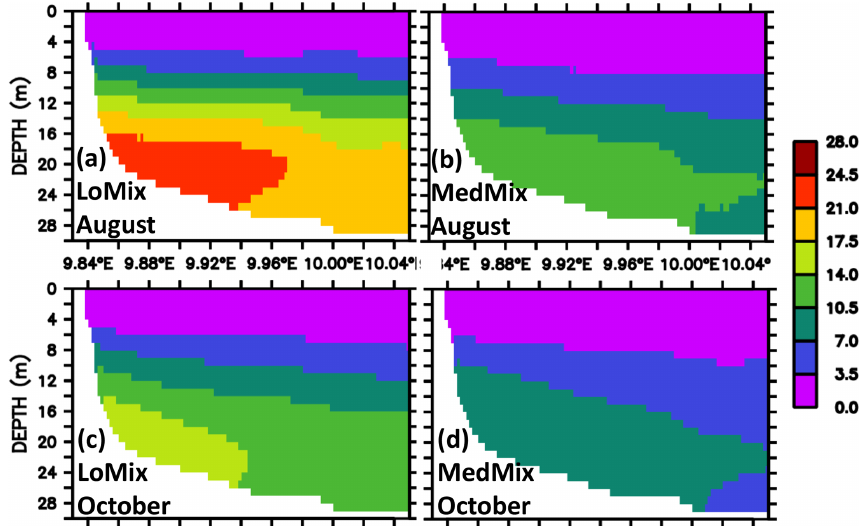
Figure 10. Simulated climatological estimate of local ventilation. The color shading denotes the time elapsed (age) since water parcels have been in contact with the atmosphere in units of days. Sections along EB are shown. Panels (a) and (b) refer to August calculated by the simulations LoMix and MedMix , respectively. Panels (c) and (d) refer to October calculated by the simulations LoMix and MedMix , respectively. Note that the model domain extends beyond the eastern boundary shown here (see also Fig.